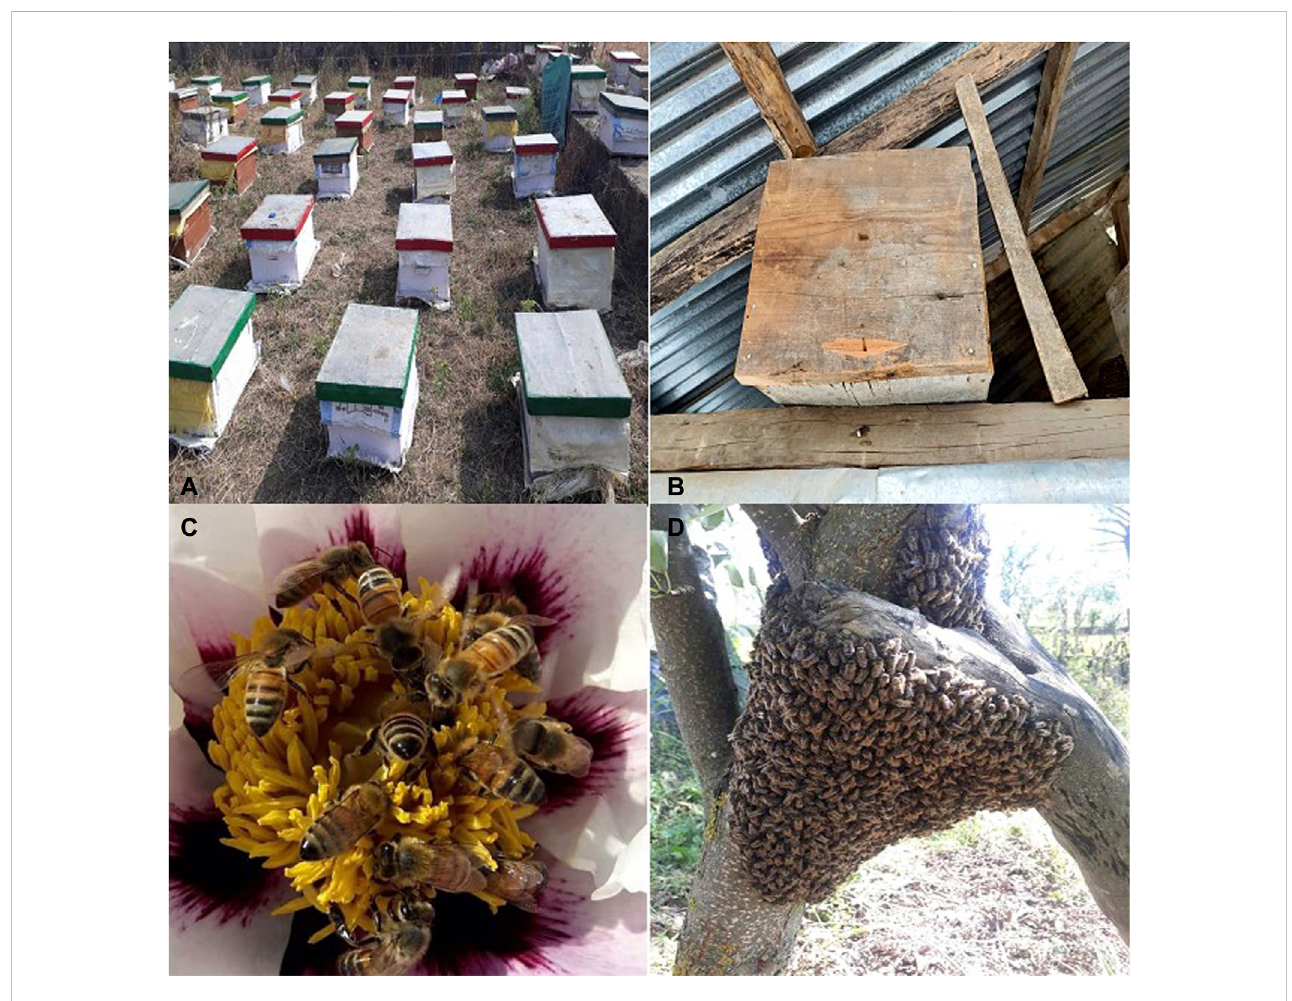
FIGURE 6 Different bees and bee related objects sited during fi eld study in J&K, India (c) Apis cerana (d) Apis mellifera (a) traditional bee hives (b) Apiary.